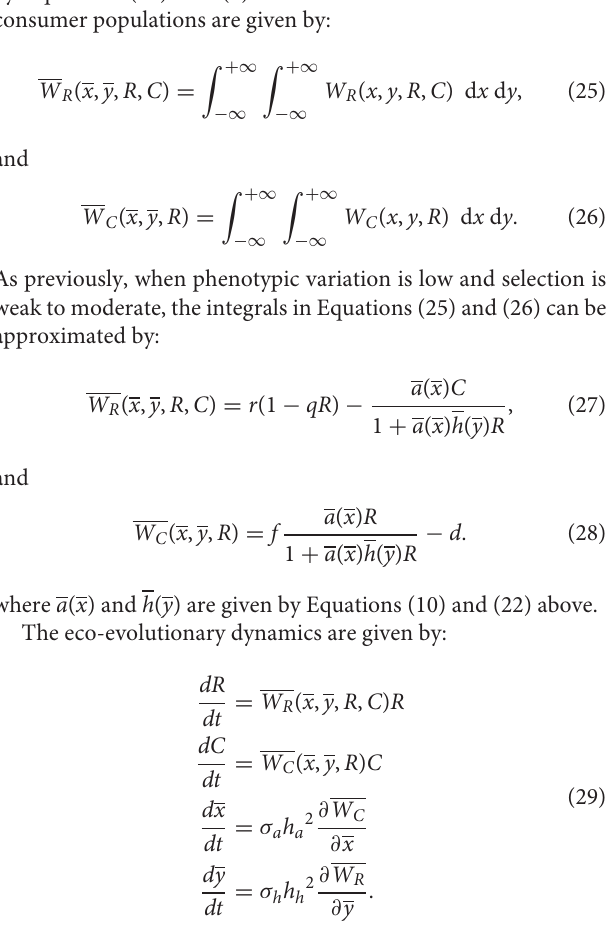
τ h 2.0 and τ h ( τ a ) 0.5] or both species ( τ a 2.0), albeit with = = = = τ h 2.0), collapse prevents trait evolution (E,I,M) . = = 5.0, q 0.04, e 0.2, d 0.1, σ a 0.5, σ h = = = = = =